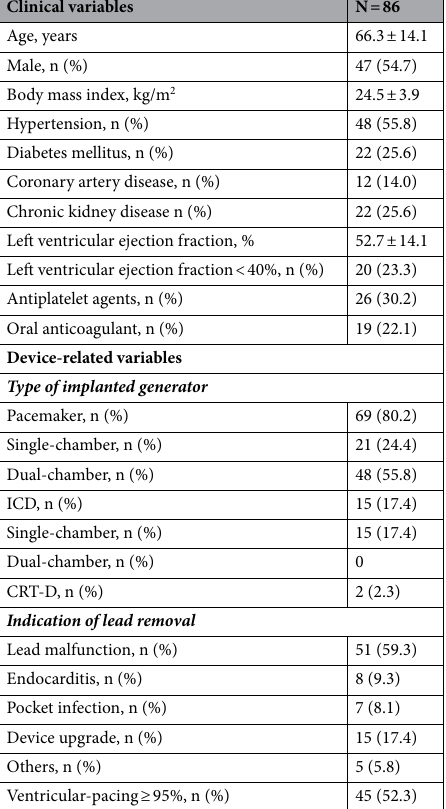
Table 1. Demographic and baseline characteristics. CRT-D cardiac resynchronization therapy-defibrillator, ICD implantable